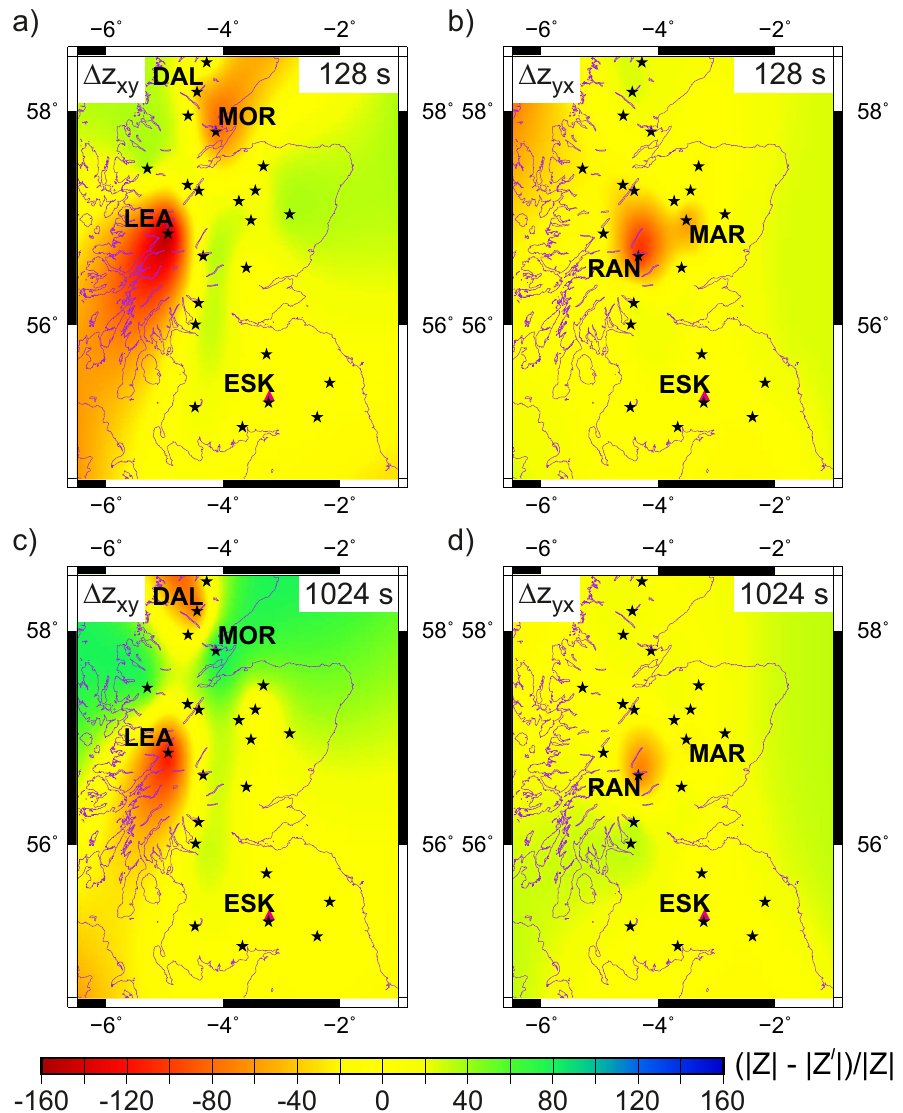
Fig. 5. Relative percentage differences: (a) D Z xy and (b) D Z yx at 128 s; (c) D Z xy and (d) D Z yx at 1024 s interpolated using bicubic splines (Smith & Wessel,